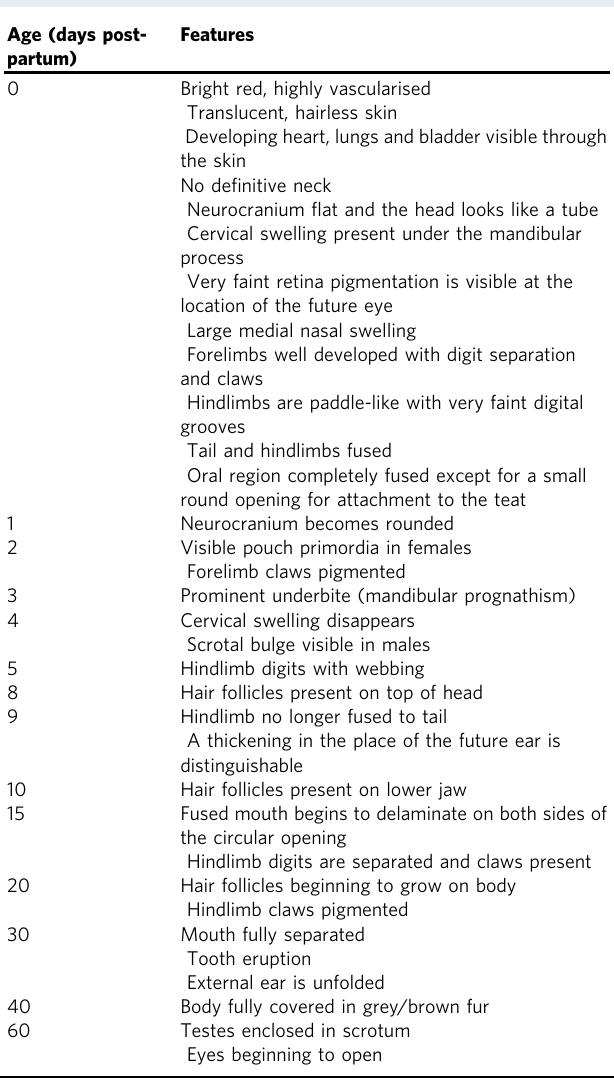
Table 1 Features of postnatal development in S. crassicaudata